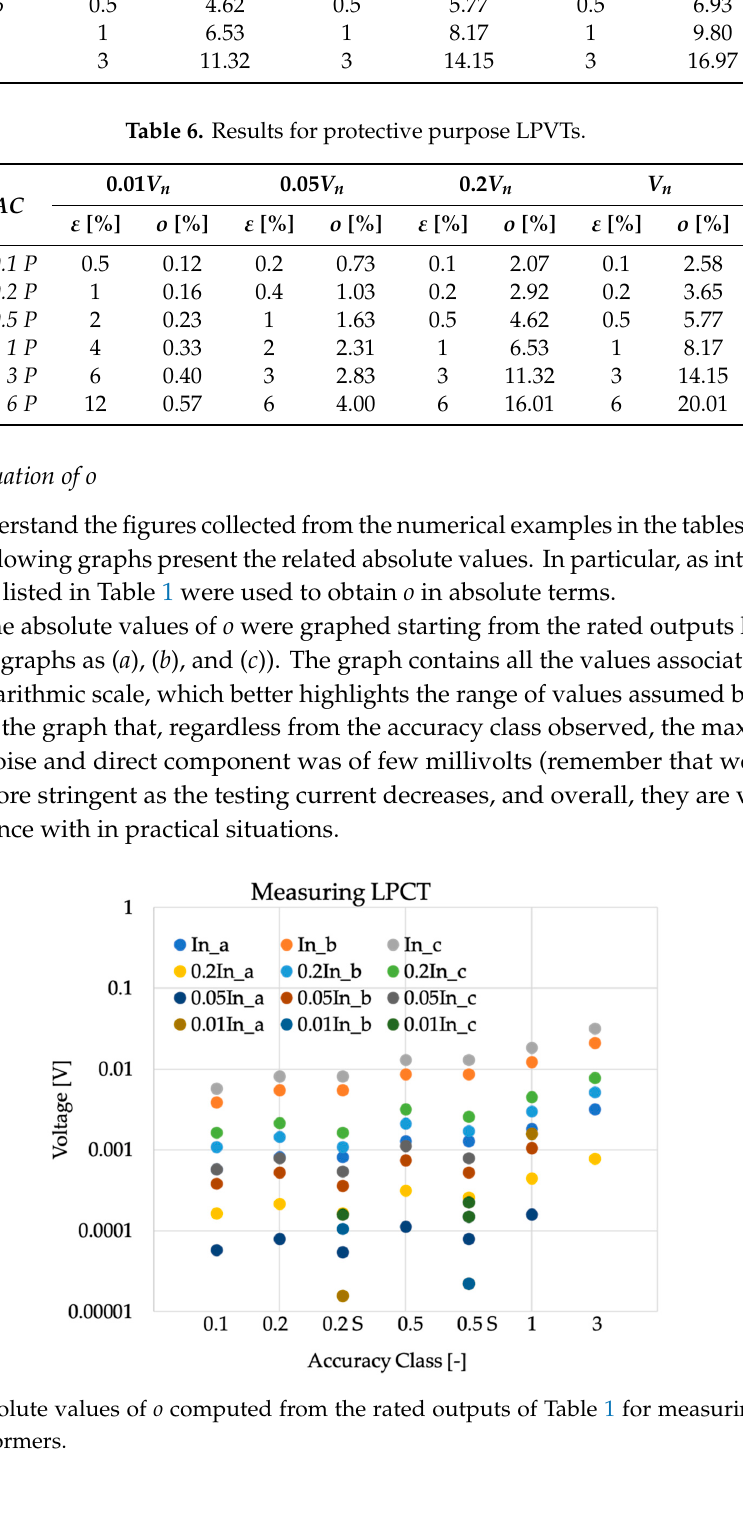
Table 5. Results for measuring purpose LPVTs.